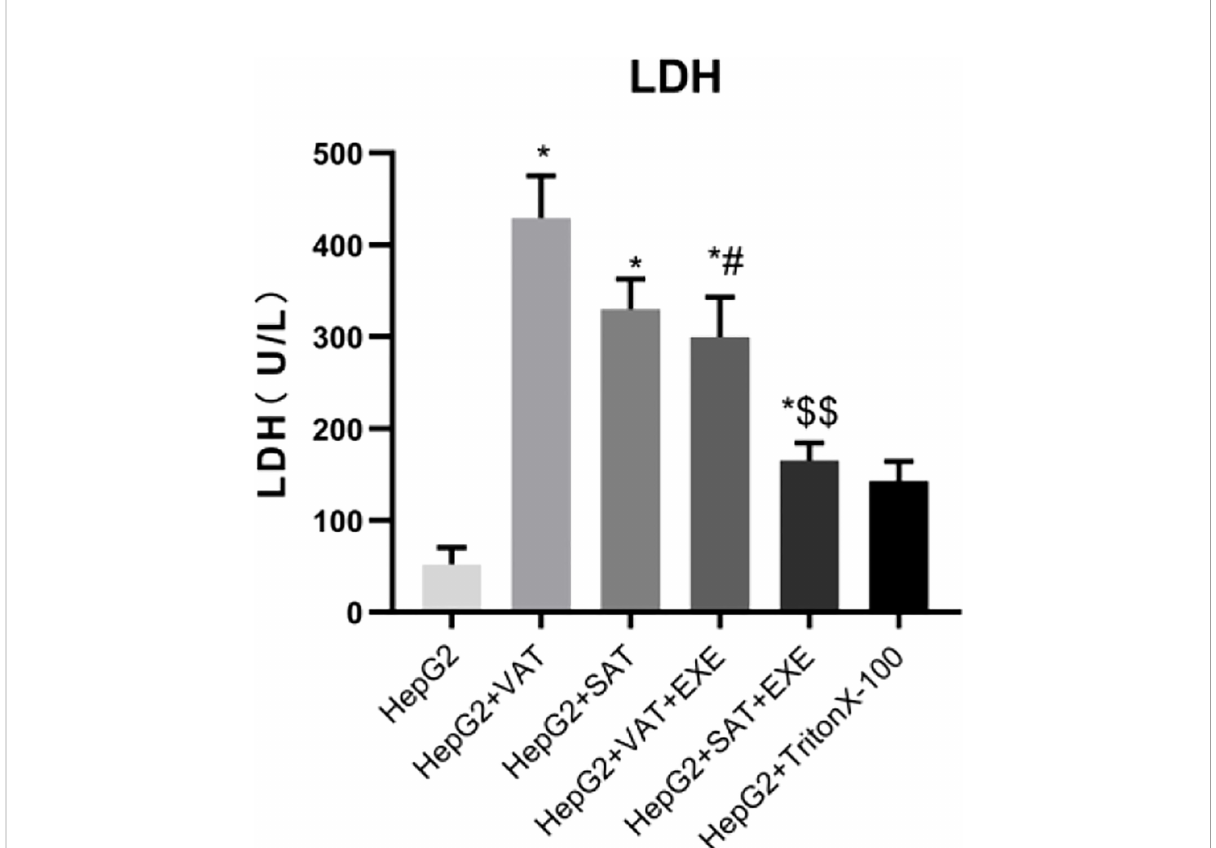
FIGURE 1 The content of LDH in supernatant of each group. Data are means ± SEM, n = 3/group, *P < 0.05 vs. HepG2 group; # P < 0.05 vs. HepG2 + VAT group; $$ P < 0.01 vs. HepG2+SAT